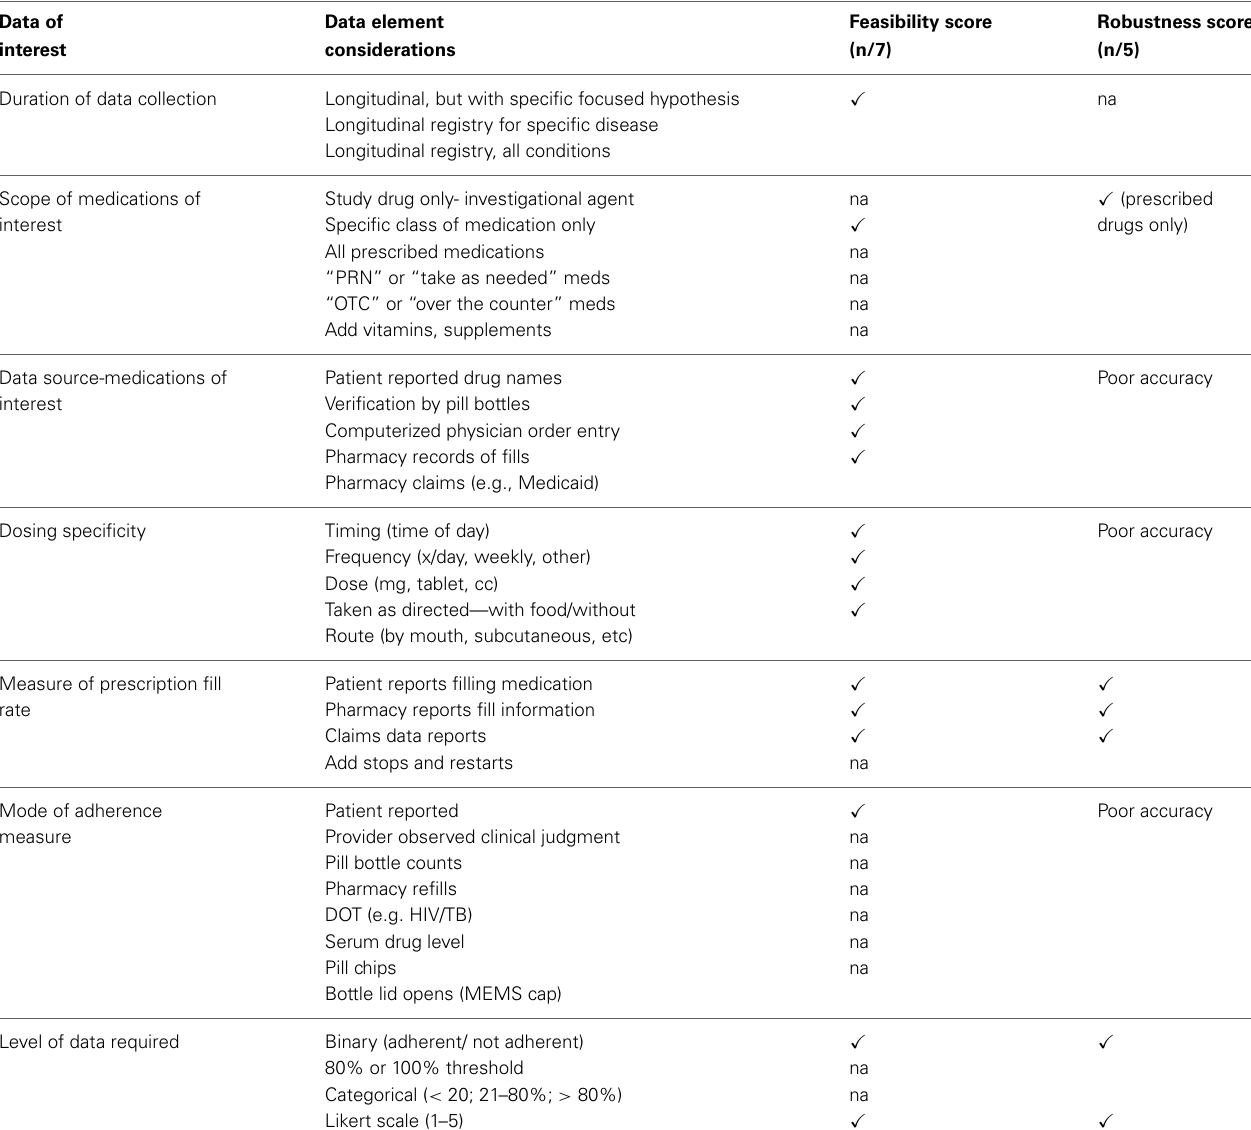
Table 1A | Process matrix: data collection considerations for medication adherence variable